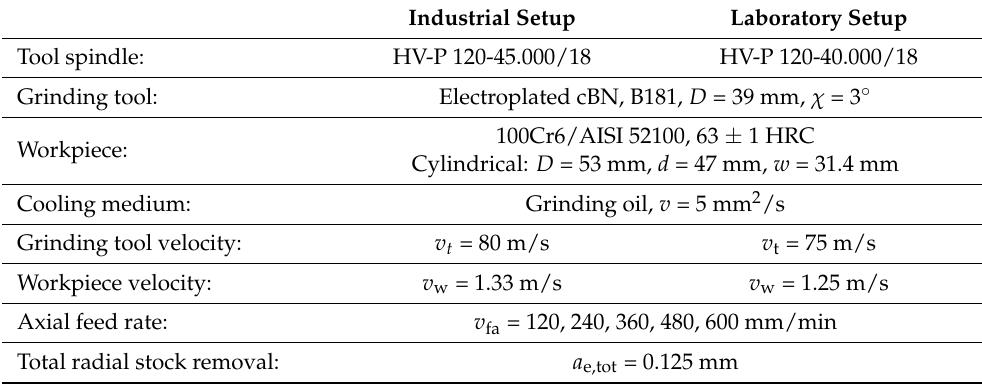
Table 1. Experimental conditions for grinding investigations. Industrial Setup Laboratory